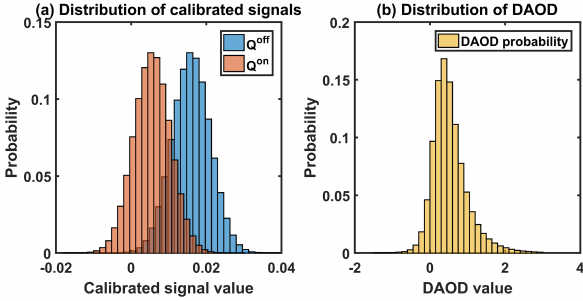
Figure 3. Effect of the non-linearity on the DAOD distribution for a low reflectivity (0.016 ice and snow cover). Panel (a) shows that the online and offline calibrated signals are normally distributed. A sig- nificant part of online calibrated signals (orange) is negative, which makes the corresponding double shots unusable (undefined loga- rithm). Panel (b) shows that the DAODs corresponding to the usable calibrated signals are not normally distributed, and they present a bias and are skewed. The true DAOD is 0.53 whereas the mean of the distribution is about 0.54, which leads to a bias on the X CH approximately + 34ppb